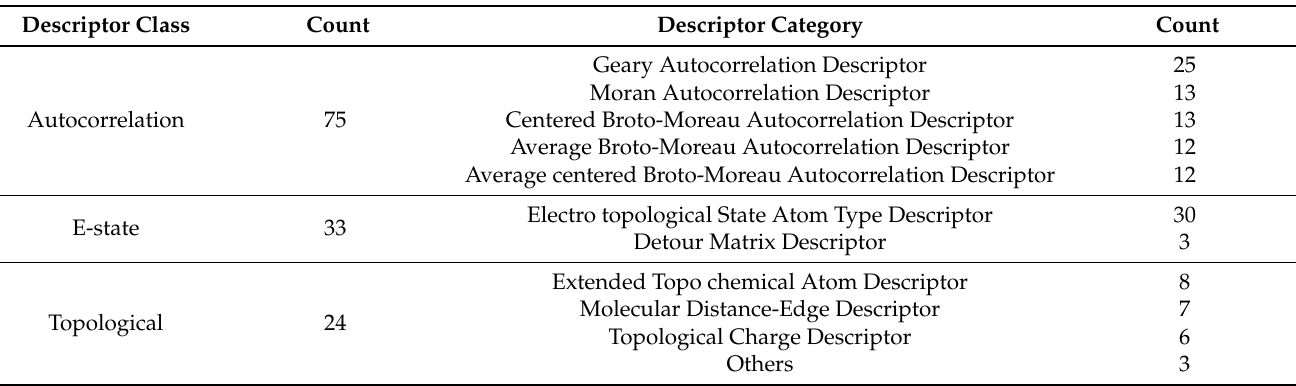
Table 3. The total number of descriptors in each significant descriptor class, with associated descriptor